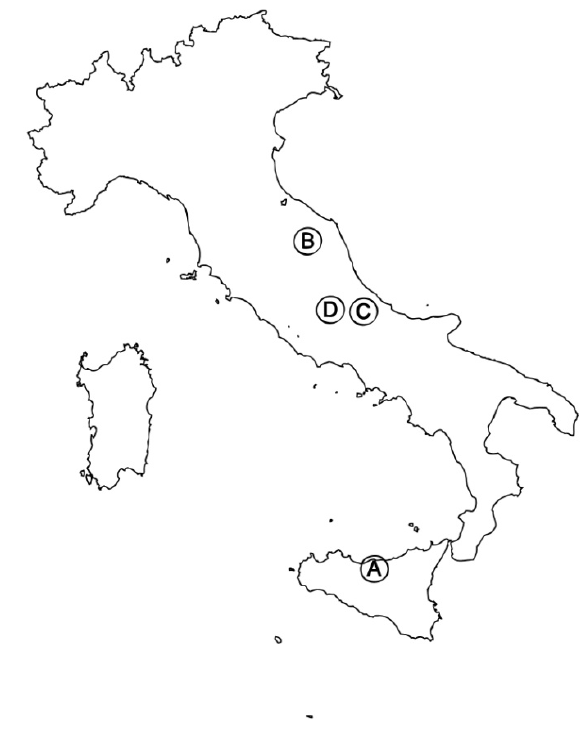
Figure 1. Map of the samples’ origins: Madonie ( A ), Marche ( B ), Majella ( C ) and Mt. Velino ( D ) are